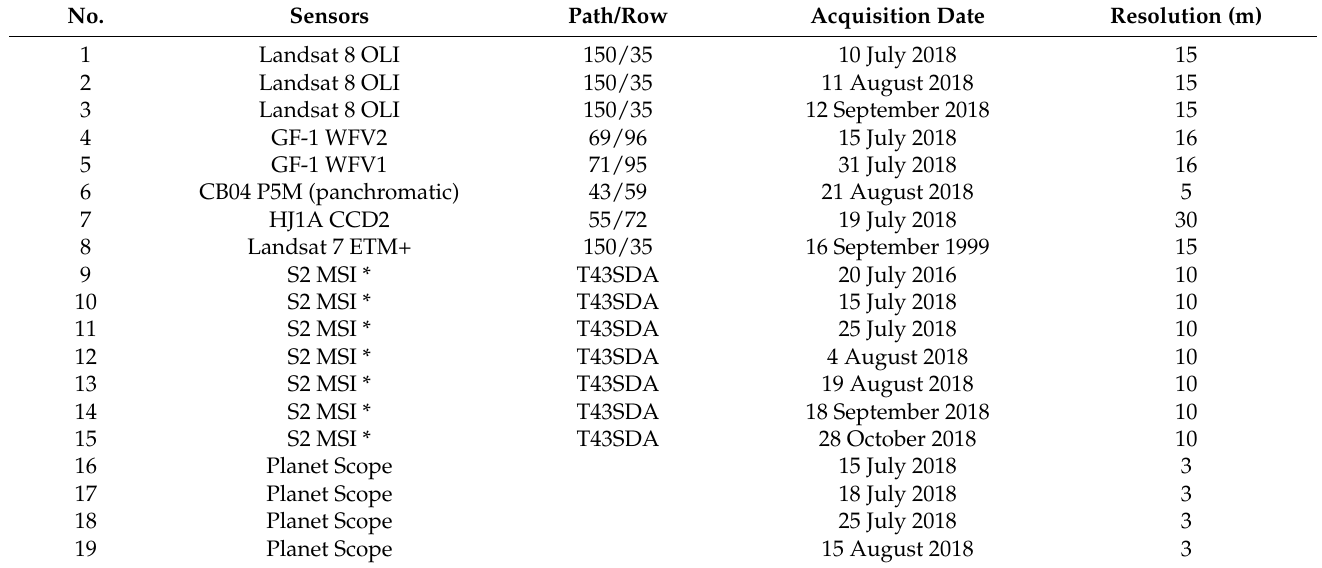
Table 1. The data resources used in this